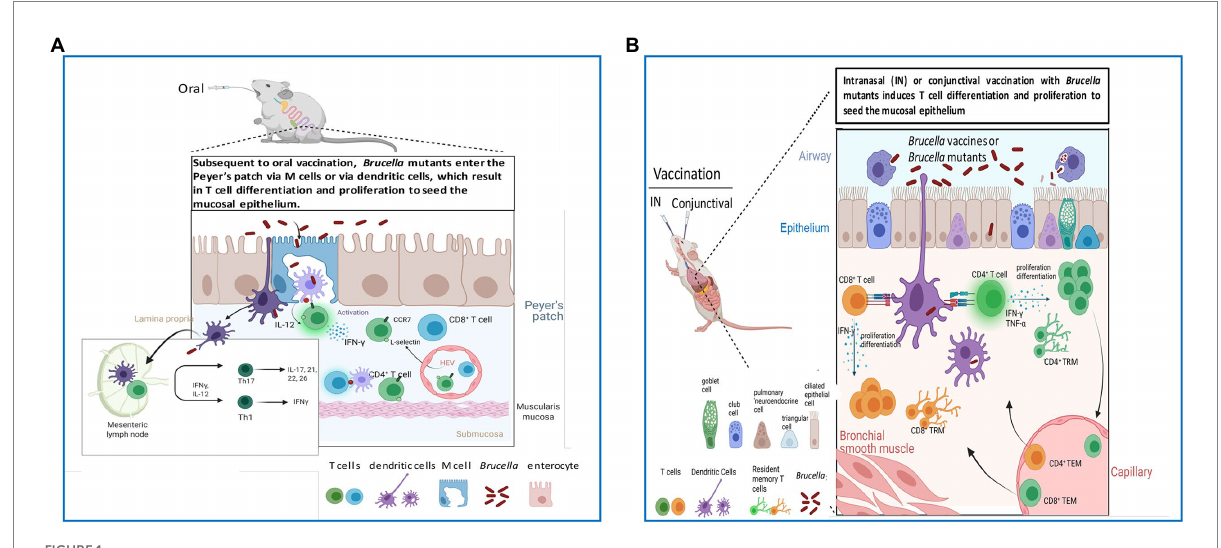
FIGURE 1 Mucosal routes of vaccination improve host capacity to target T cells to infiltrate the epithelium to combat Brucella pathogens. (A) Oral vaccination with Brucella vaccines or mutant strains enables stimulation of IFN- γ -producing T cells in the Peyer’s patch and eventual dissemination into regional lymph nodes (LNs) and mucosal epithelium. (B) Intranasal (IN) and conjunctival vaccination with Brucella vaccines or mutant strains enables induction of resident memory T cells (TRMs) to reside in the epithelium to combat reinfection with virulent Brucella